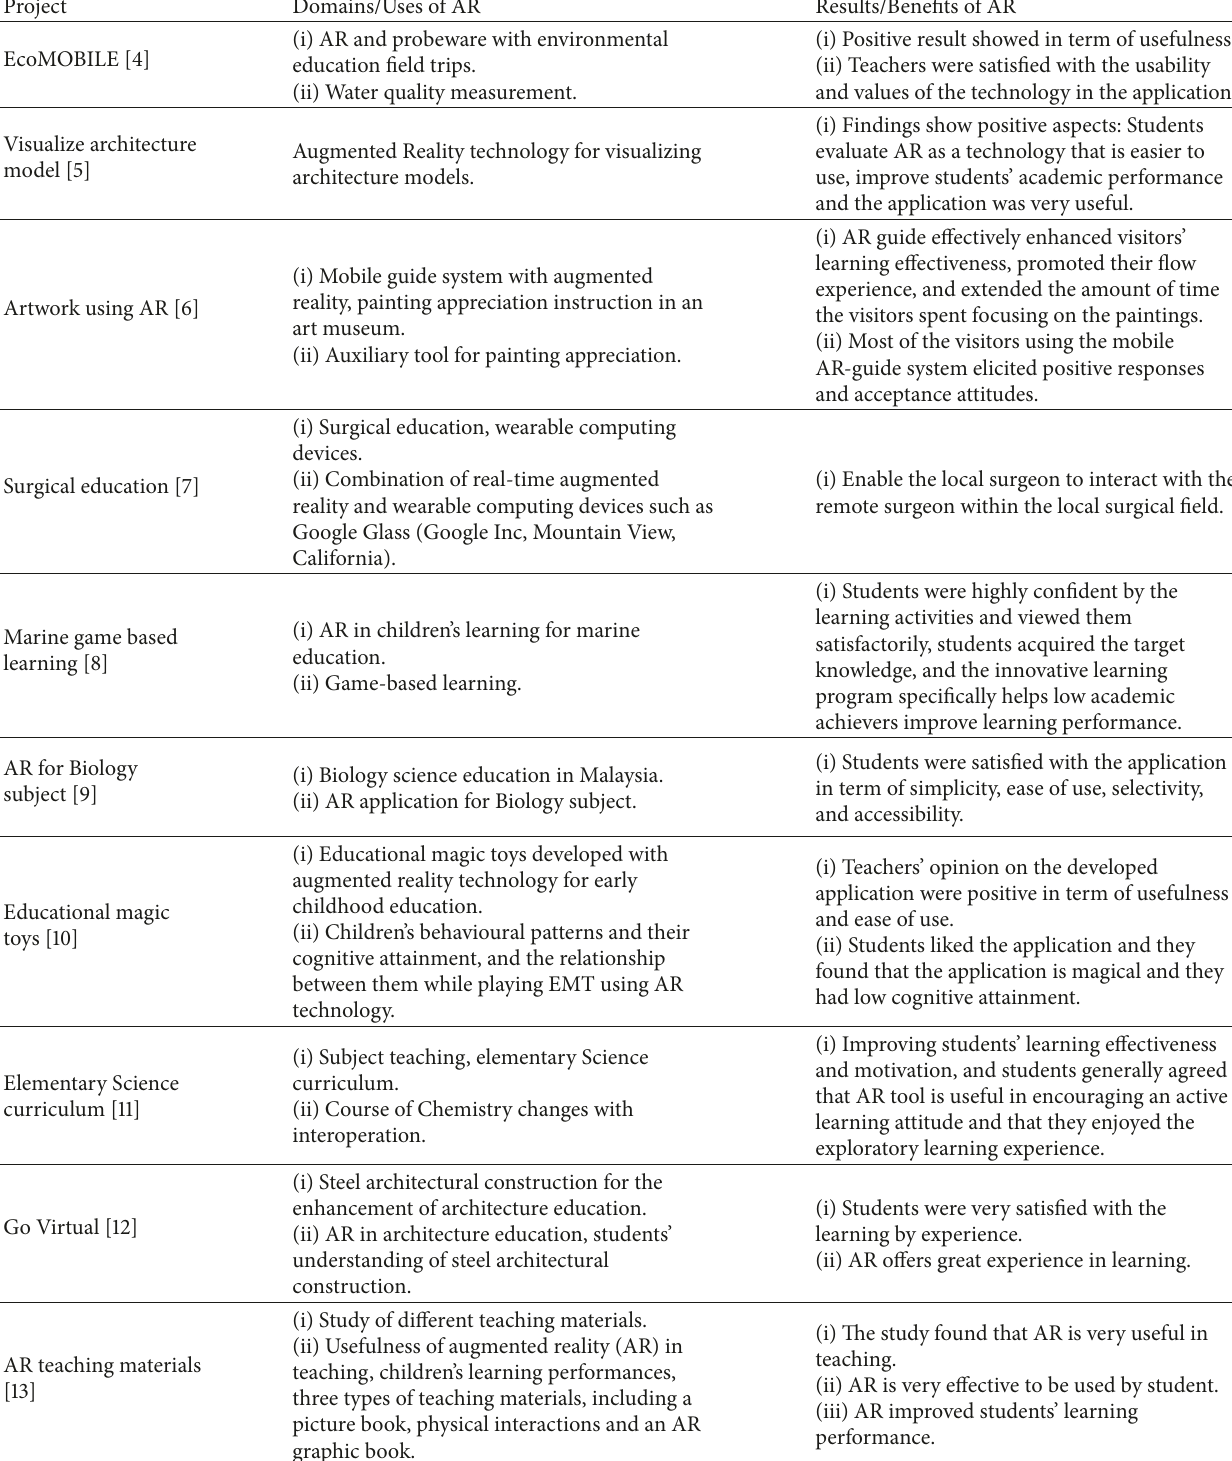
Table 1: AR researches on